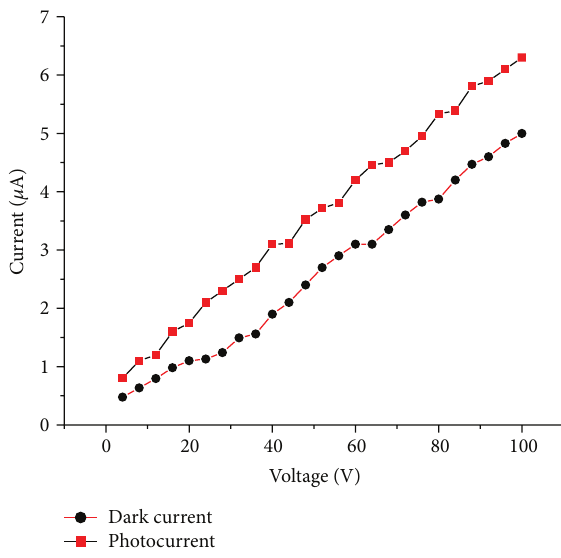
Figure 9: Photoconductivity plot of